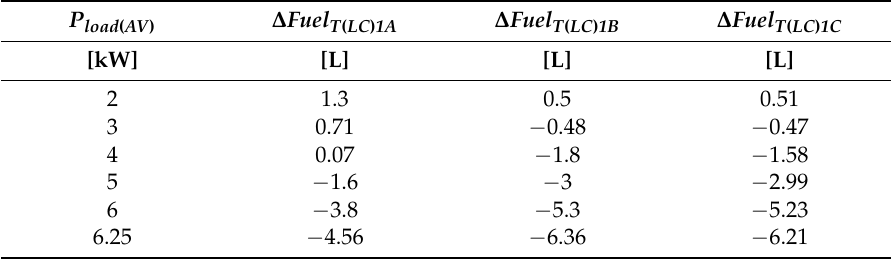
Table 9. Fuel economy under variable load demand for the RTO1 strategy using different k fuel .